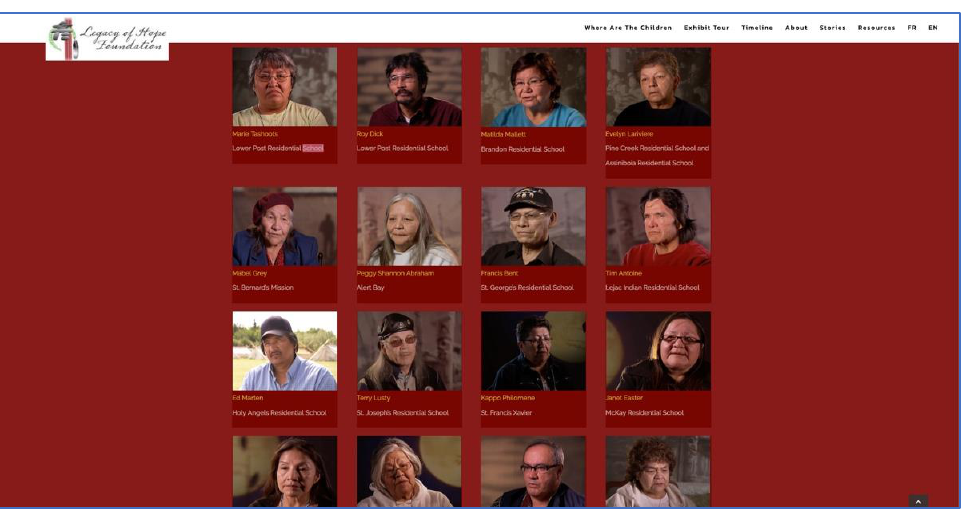
Figure 1. Screenshot of the Survivor Stories page of the Legacy of Hope ’s Where Are the Children Website showing thumbnail views of Residential Schools Survivors (The Survivor interviews are available on the stories page at: https://legacyofhope.ca/wherearethechildren/, (accessed on 1 April 2022)).